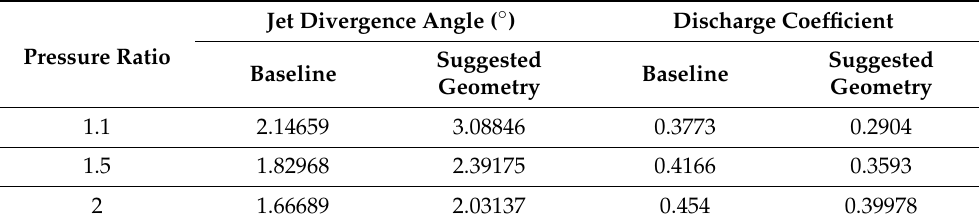
Figure 19. Streamlines of the labyrinth seal under a pressure ratio of 2 for ( a ) baseline and the ( b ) suggested design.